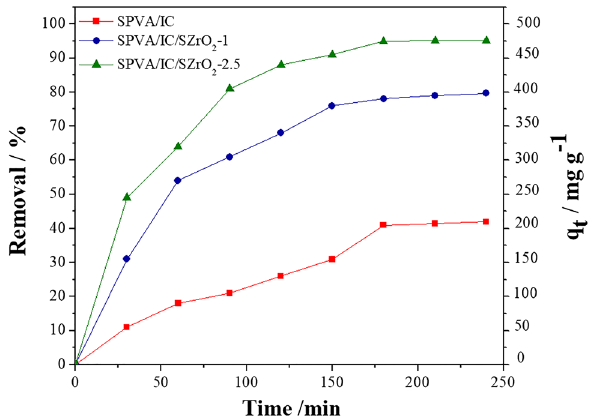
Figure 5. Adsorption kinetics of Cefotaxime onto composite beads at C 0 ; 100 mg L −1 , dose of adsorbent beads 0.2 mg mL −1 , at 25 °C and pH 6.